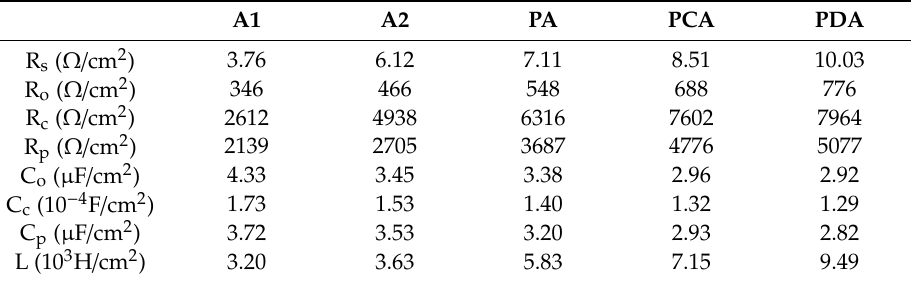
Figure 4. The equivalent electrical circuit (EEC) used to fit the electrochemical impedance spectra (EIS) test data. Table 3. Fitted values of parameters from the EEC.